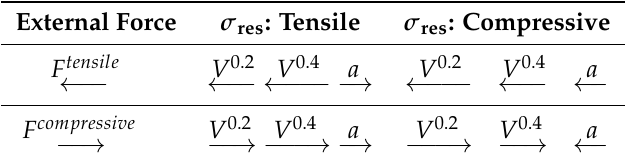
Table 1. Velocity change for different combinations of residual stresses and external